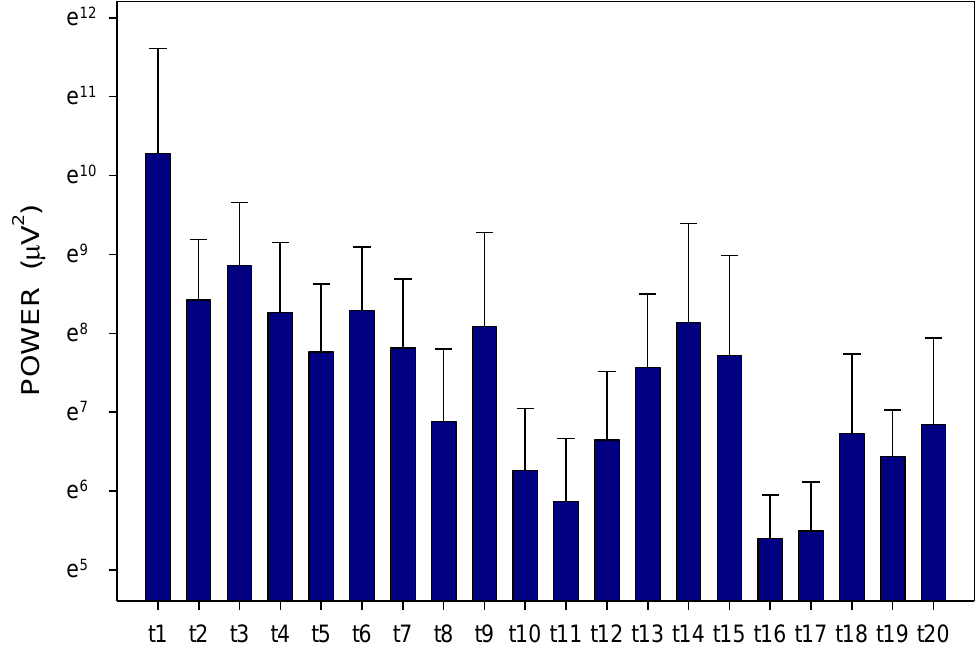
Figure 8. Electrogastrography. EGG power in animals with a shorter small bowel transit time (272 ± 60 min); mean + standard deviation. Outliers omitted. Axis Y: natural logarithm scale. Explanatory note: t: 15-min study recordings after galantamine administration (t1: time interval between 0–15 min ... t20: time interval between 286–300 min).